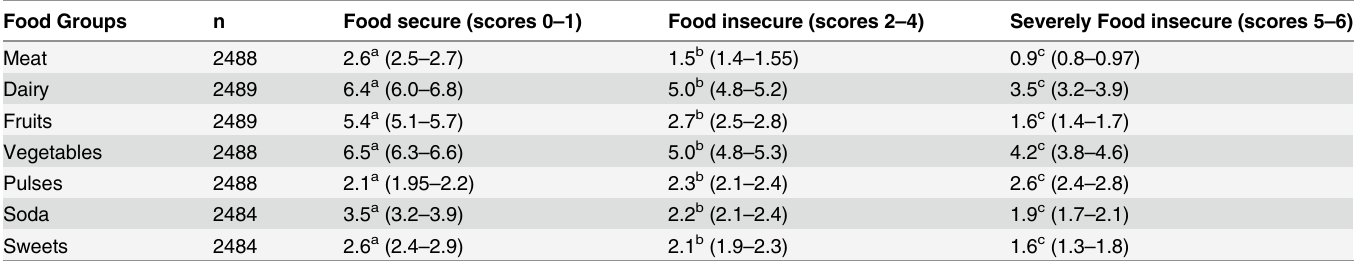
Table 3. Mean dietary intake of food categories by Palestinian refugee households and by levels of food security. Food